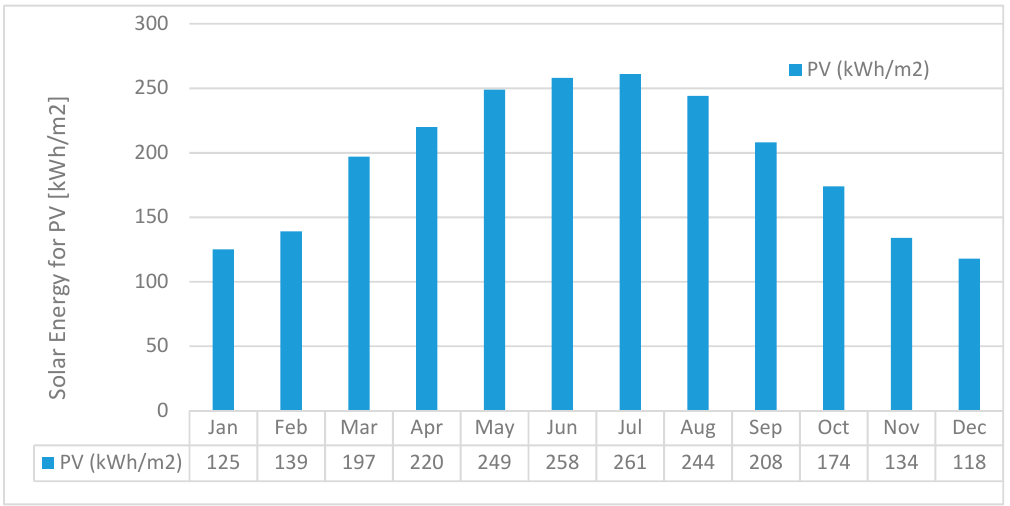
Figure 13. Monthly mean solar energy for the PV system for the Ras Ghareb zone.